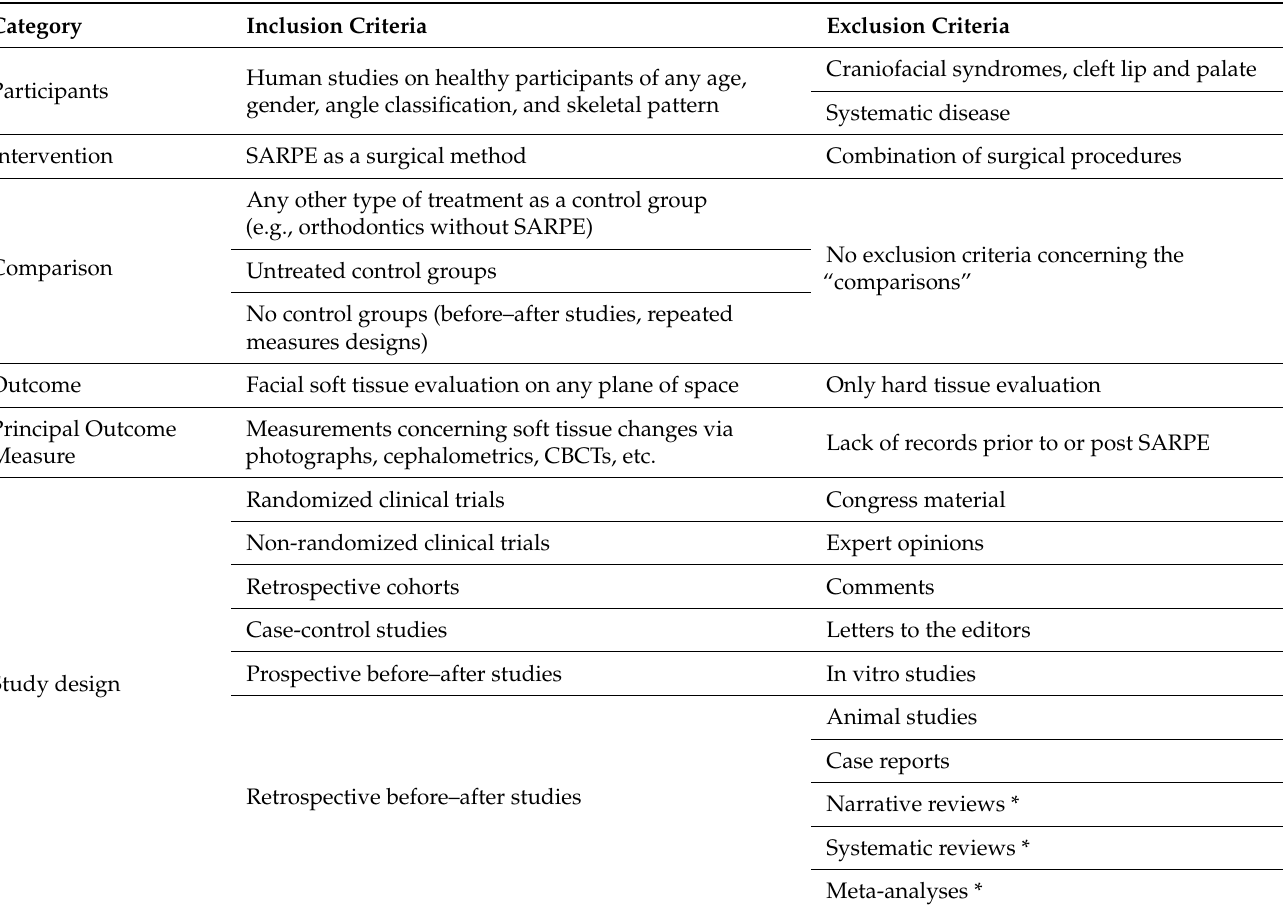
Table 2. A priori inclusion and exclusion